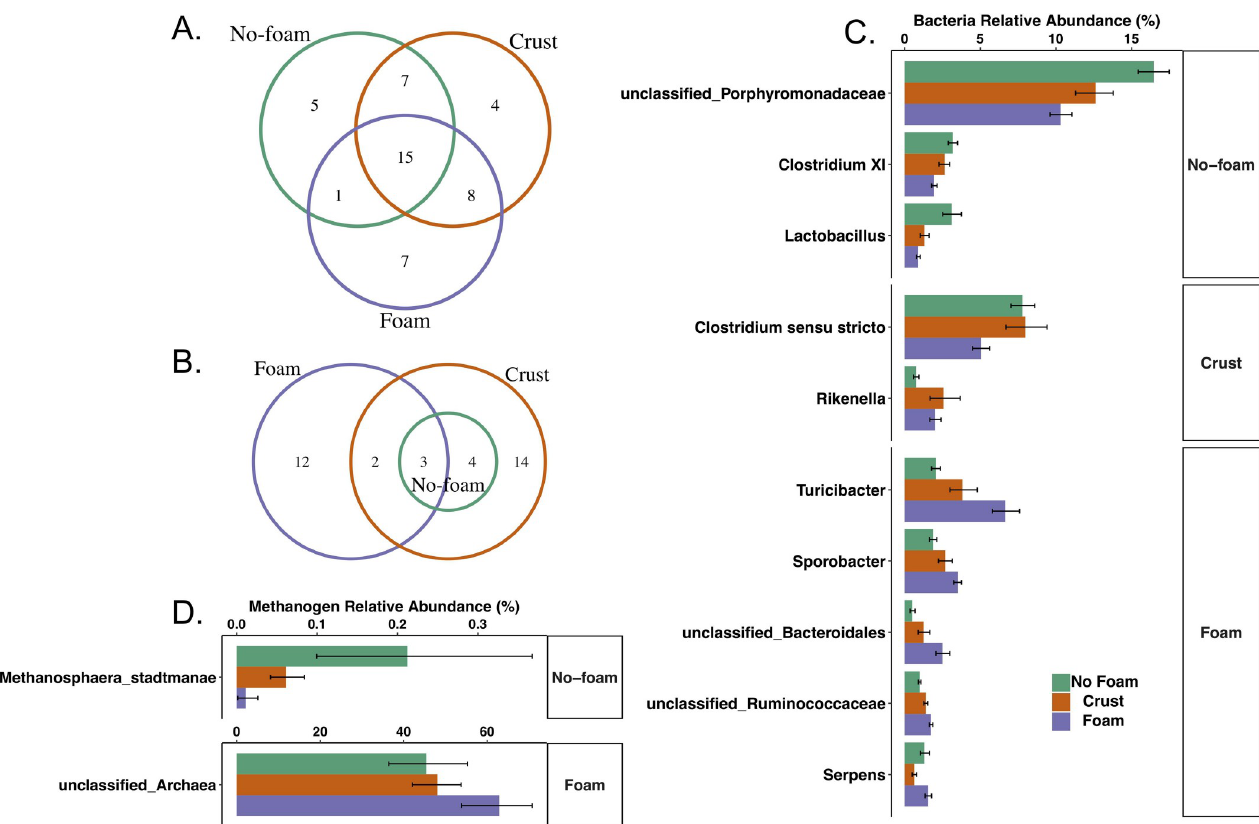
Fig 5. The distribution of shared and unique A) bacterial and B) methanogenic core of no-foam, crust, and foam manure samples. The numbers represent the operational taxonomic unit (OTU) counts. Panel C shows the ten most relatively abundant bacterial groups at the genus level where relative abundances were significantly different among no-foam, crust, and foam manures. Methanogen groups that differed significantly in relative abundance among different types of manure are shown in panel D. Individual bar represents the average of a microorganism relative abundance in the specified manure type, while individual error bar represents the 95% confidence interval calculated using bootstrapping method. Within panel C and D, the labels on the right side indicate the manure type in which the bacterial or methanogen groups were the most relatively abundant